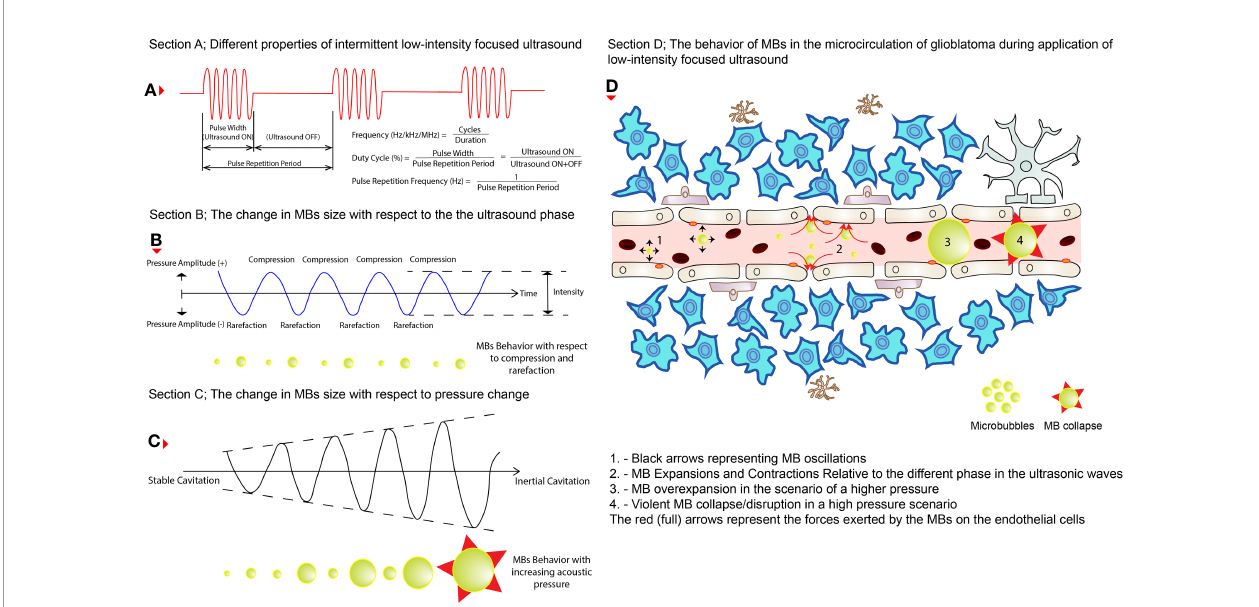
FIGURE 2 | The behaviors of MBs during LIFU application. (A) The different properties of an intermittent pulsed LIFU. (B) How MBs change size (shown below the wave) during the two phases of the ultrasound (i.e., compression and rarefaction). (C) How do MBs increase in size (shown below the wave) while pressure is increased eventually resulting in violent collapse? (D) How do these changes affect the permeability of the cerebral vasculature in glioblastoma tissues? The black (short arrows) arrows represent oscillations on the left, expansions and contractions in the middle, and eventually collapse on the right of the illustration. The red (full) arrows represent the pressure exerted by the MBs on the ECs of the cerebral blood